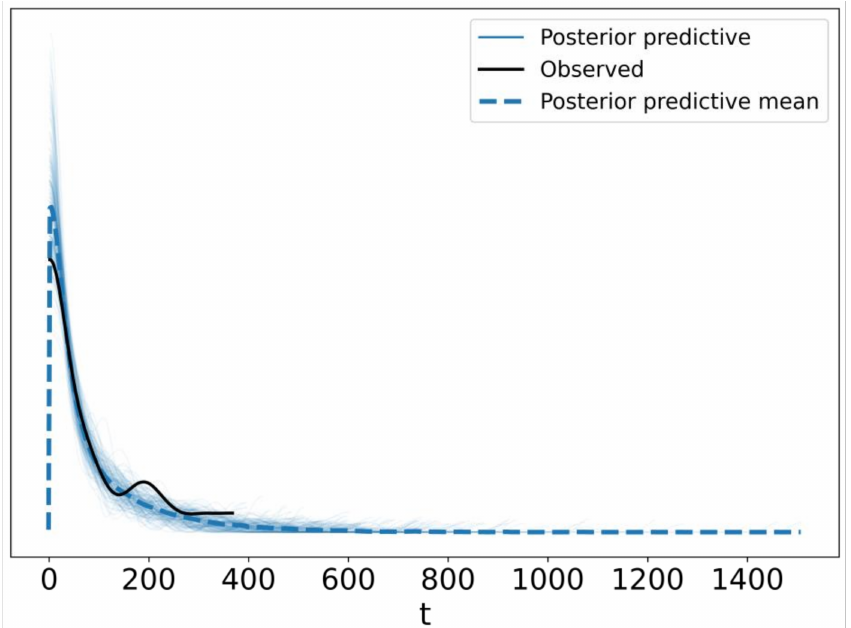
Figure 7. Comparison between the posterior prediction and the observed data.